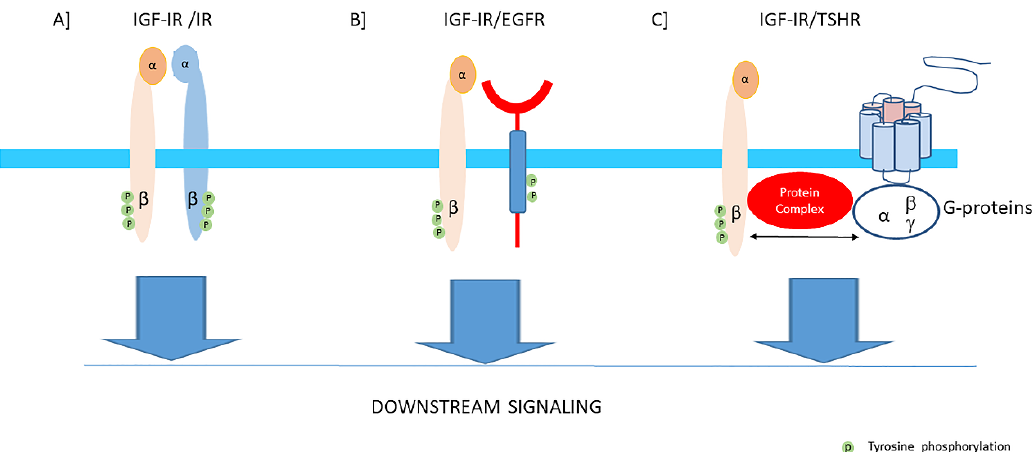
Figure 3. The IGF-I receptor may form hybrids with the insulin receptor, many other tyrosine kinase receptors outside the insulin-IGF system and G-protein coupled receptors. The figure shows three examples: ( A ) Hybrids may be formed consisting of an alpha-beta subunit of the IGF-IR linked by disulfide bonds to an alpha-beta subunit of the IR. Downstream signaling of both receptors converge via the canonical PI3K-Akt and ERK signaling pathways. Most functional studies have found that hybrid receptors behave more like IGF-IRs than IRs (See also text). ( B ) Hybrids may be formed consisting of an alpha-beta subunit of the IGF-IR linked and a monomer of the epidermal growth factor receptor (EGFR) which is also a tyrosine kinase receptor. Downstream signaling of both receptors converge via the canonical PI3K-Akt and ERK signaling pathways. Therefore, inhibition of one receptor of these hybrids may shift the signaling pathway in favor of the other available counterpart receptor. ( C ) The Thyroid Stimulating Hormone Receptor (TSH receptor), a typical G-protein coupled receptor, may form functional hybrids with the IGF-IR in the cellular membrane by forming a common protein complex. Bidirectional crosstalk between the IGF-IR and TSHR has been demonstrated. Stimulation of the IGF-IR by IGF-I / IGF-IR agonists may trigger the classical signaling pathway of the IGF-IR, leading to downstream kinase-cascade signaling activation. In addition, stimulation of the IGF-IR by IGF-I / IGF-IR agonists may also utilize components of G-protein coupled receptor (GPCR) signaling and activate pathways conventionally used by TSHR.